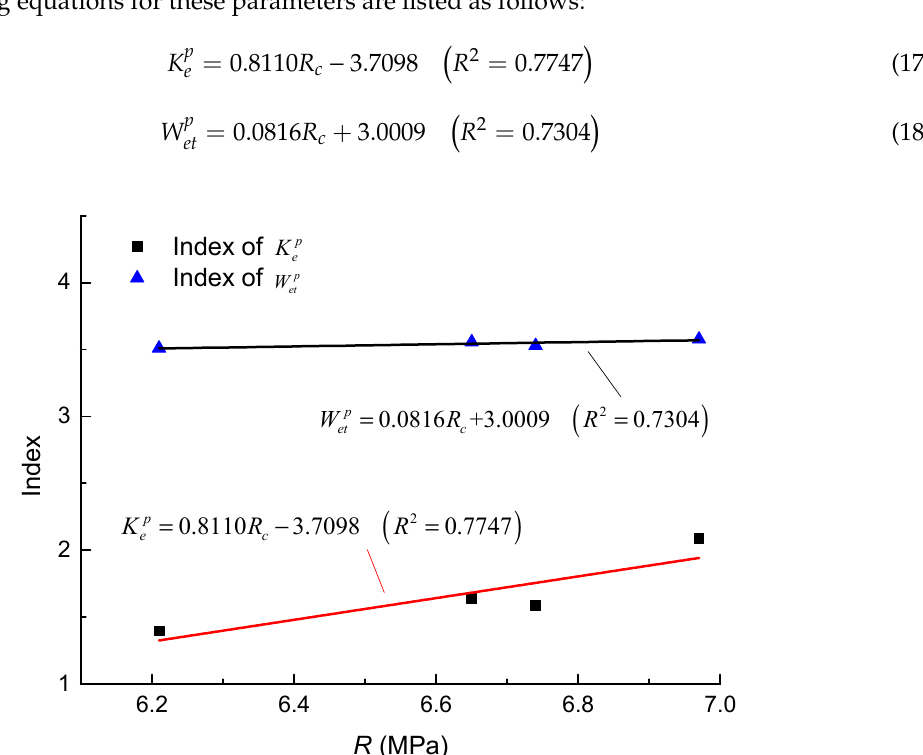
Figure 13. Relationship between indexes K